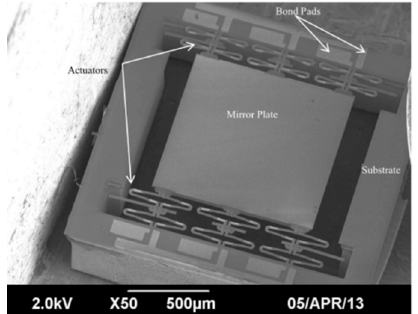
Figure 32. SEM of an actuator array with an elevated mirror plate. (Reprinted with permission from Reference [59] IEEE).